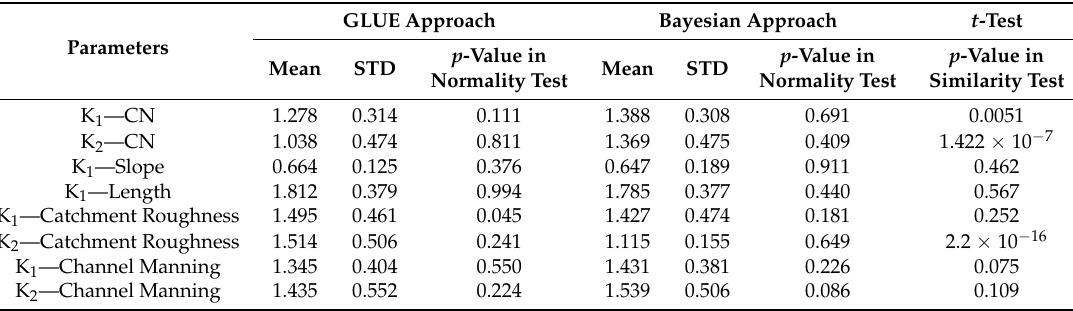
Table 3. Accepted model